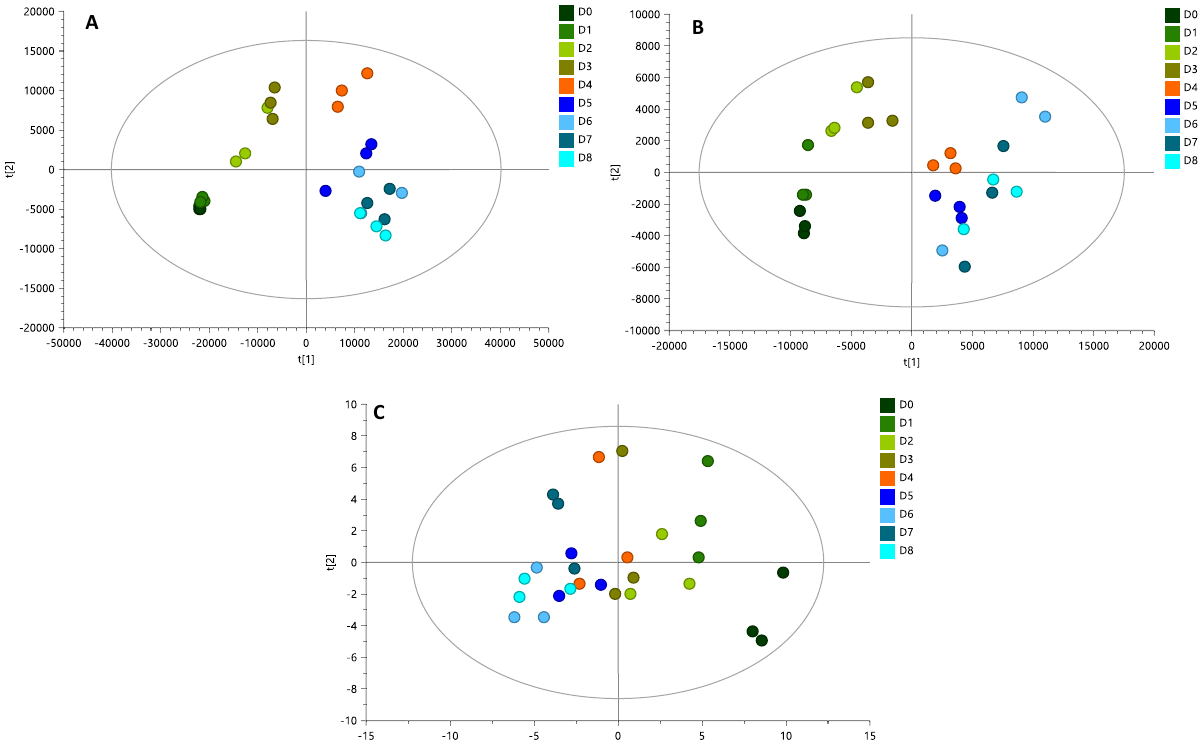
Figure 2. PCA score plots for all fermentation samples. ( A ) MF by LC–MS( +): R 2 (cum): 0.875, Q 2 (cum): 0.826; ( B ) MF by LC–MS(-): R 2 (cum): 0.876, Q 2 (cum): 0.77; ( C ) MF by GC–MS: R 2 (cum): 0.724, Q 2 (cum):